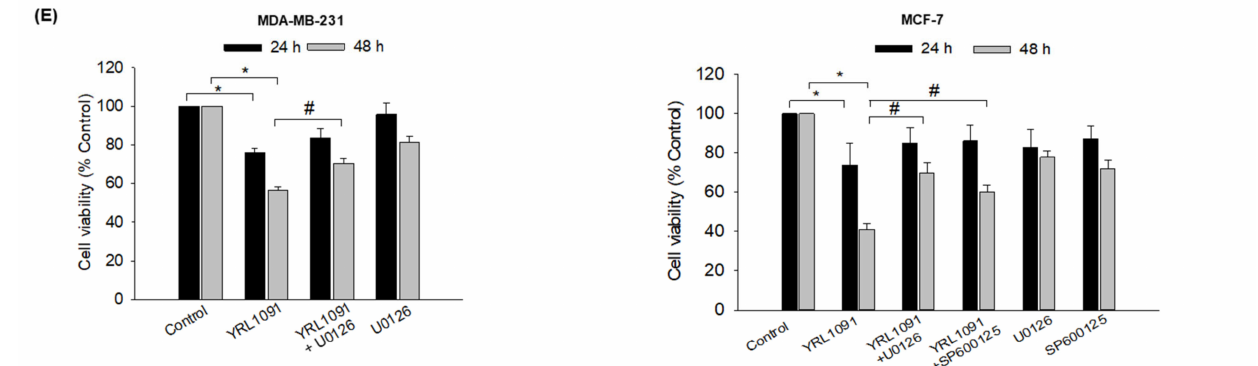
Figure 3. Roles of MAPKs in YRL1091-induced vacuolated cells and cell death in MDA-MB-231 and MCF-7 cells. ( A , B ) Cells were treated with YRL1091 (10 and 30 µ M) for 24 h. ( A ) The phosphorylated ERK1/2 and ( B ) JNK were determined by western blotting. β -Actin was used for normalization. ( C – E ) Cells were pretreated for 2 h with ERK and JNK inhibitors (U0126 and SP600125, respectively, at 20 µ M) and then YRL1091 (30 µ M) was added. ( C ) The levels of LC3B protein were measured after 24 h of treatment using western blotting. Each data point was calculated as the percentage of protein level in vehicle-treated control cells. Representative blots from at least three independent experiments were displayed. ( D ) Cell morphology after 12 h of treatment was visualized using a phase-contrast microscope. Scale bar: 20 µ m. ( E ) Cell viability at 24 or 48 h of treatment was examined by SRB assay. The cell viability of each treated group was expressed as the percentage of that in control group. Data are presented as the mean ± SEM from at least three independent experiments. * p < 0.05